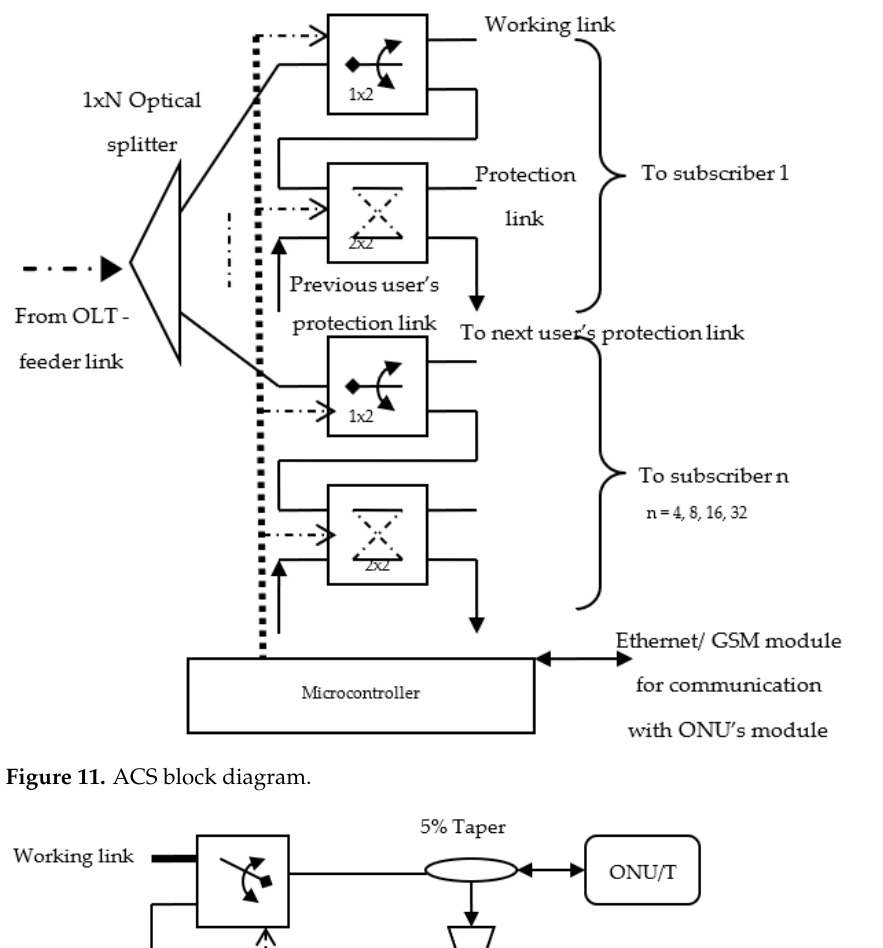
Figure 11. ACS block diagram.